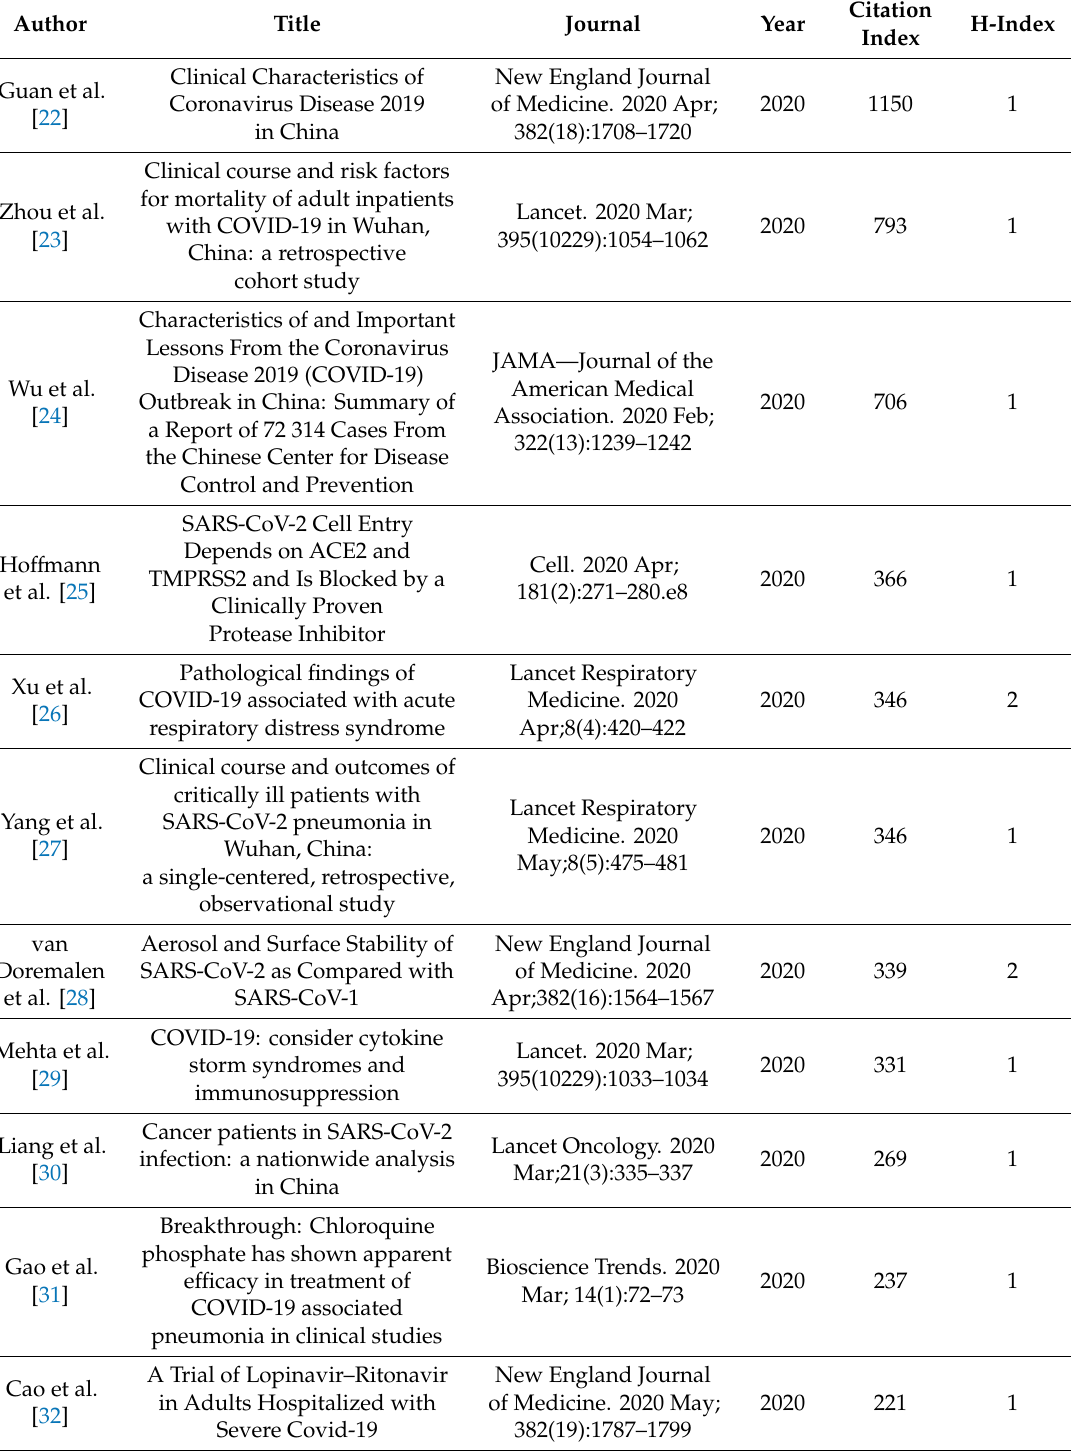
Table 1. Description of the 20 most cited publications on